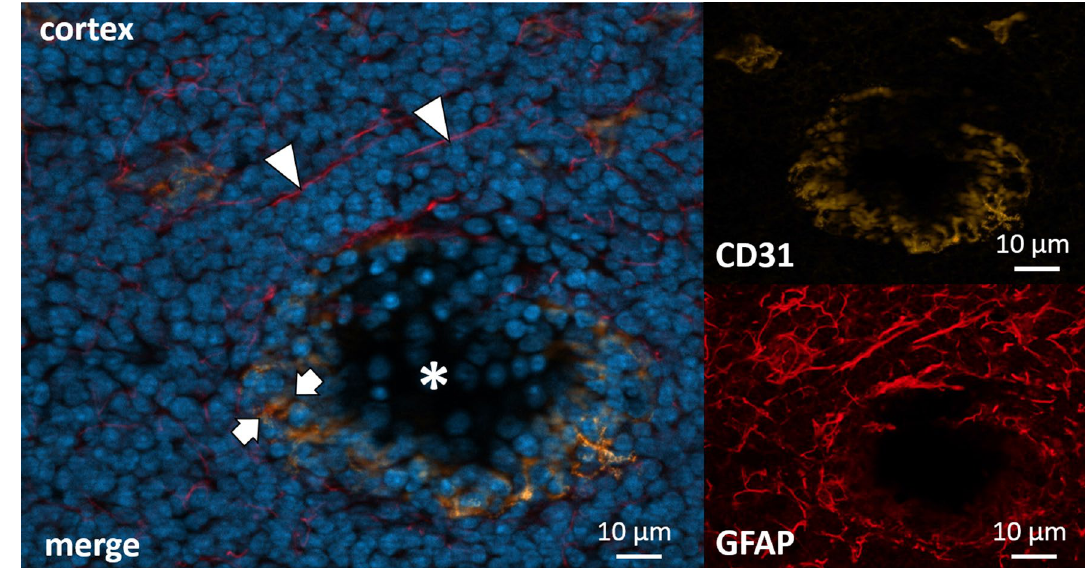
Figure 5. Cortex of a cervical lymph node. Immunohistochemical co-staining with polyclonal anti-GFAP antibody (DAKO) in red (directly conjugated) and anti-CD31 in orange, a marker for blood endothelium. DAPI for nuclear staining in blue. Colocalization between GFAP and CD31 is highlighted by arrows. Colocalization is clear but incomplete. GFAP immunoreactivity is also clearly visible in the parenchyma around the vessel (arrowheads), while CD31 is limited to the blood vessel (asterix).